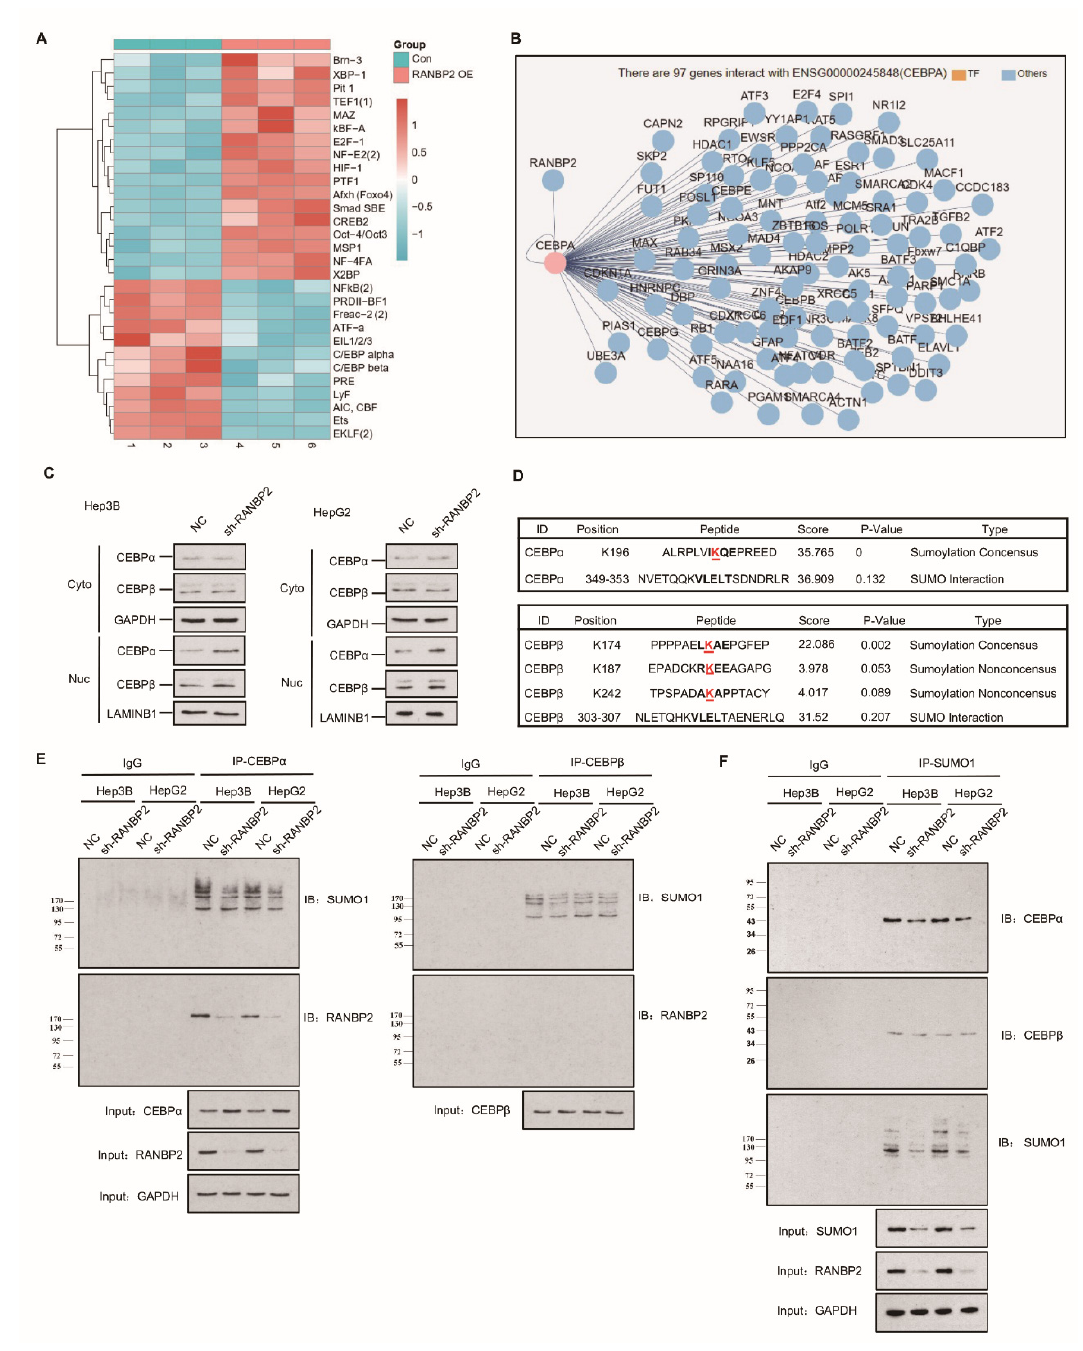
Figure 2. Endogenous RANBP2 interacts with CEBP α and downregulates its expression in HCC cells. ( A ) The transcriptional factor array revealed the potential downstream targets of RANBP2. The CEBP family, including CEBP α and CEBP β , were significantly downregulated in RANBP2-overexpressing Hep3B cells. ( B ) The potential interplay between RANBP2 and the transcriptional factor CEBP α . Though a crucial member of the same protein family, CEBP β was not predicted to interact with RANBP2. ( C ) Cell fractionation assays showed increased CEBP α and CEBP β nuclear expression but no cytoplasmic alteration upon RANBP2 knockdown. Two independent experiments were conducted. GAPDH and LAMINB1 were used as controls in cytosol and nuclei, respectively. The additional immunofluorescence study, shown in Supplementary Figure S3, revealed that CEBP α and CEBP β were inversely correlated with RANBP2. ( D ) Schematic representation of the predicted SUMO-conjugation motifs in the CEBP α and CEBP β proteins. GPS-SUMO software indicated the predicted Lysine(K)-196 and Lysine(K)-174 SUMO-conjugation motifs and corresponding scores. ( E ) Co-immunoprecipitation confirmed the endogenous interaction of CEBP α and RANBP2. Additionally, immunoblotting with SUMO1 provided information of all RANBP2-associated SUMOylated proteins that potentially interacted with CEBP α . Meanwhile, no CEBP β –RANBP2 binding was detected. Equal CEBP α or CEBP β loading in the IP panel was pre-verified. ( F ) CEBP α